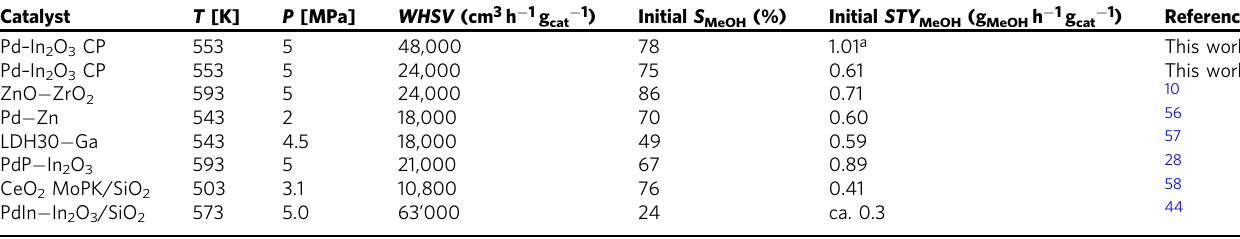
Table 2 Comparison of heterogeneous catalysts for CO 2 hydrogenation to methanol